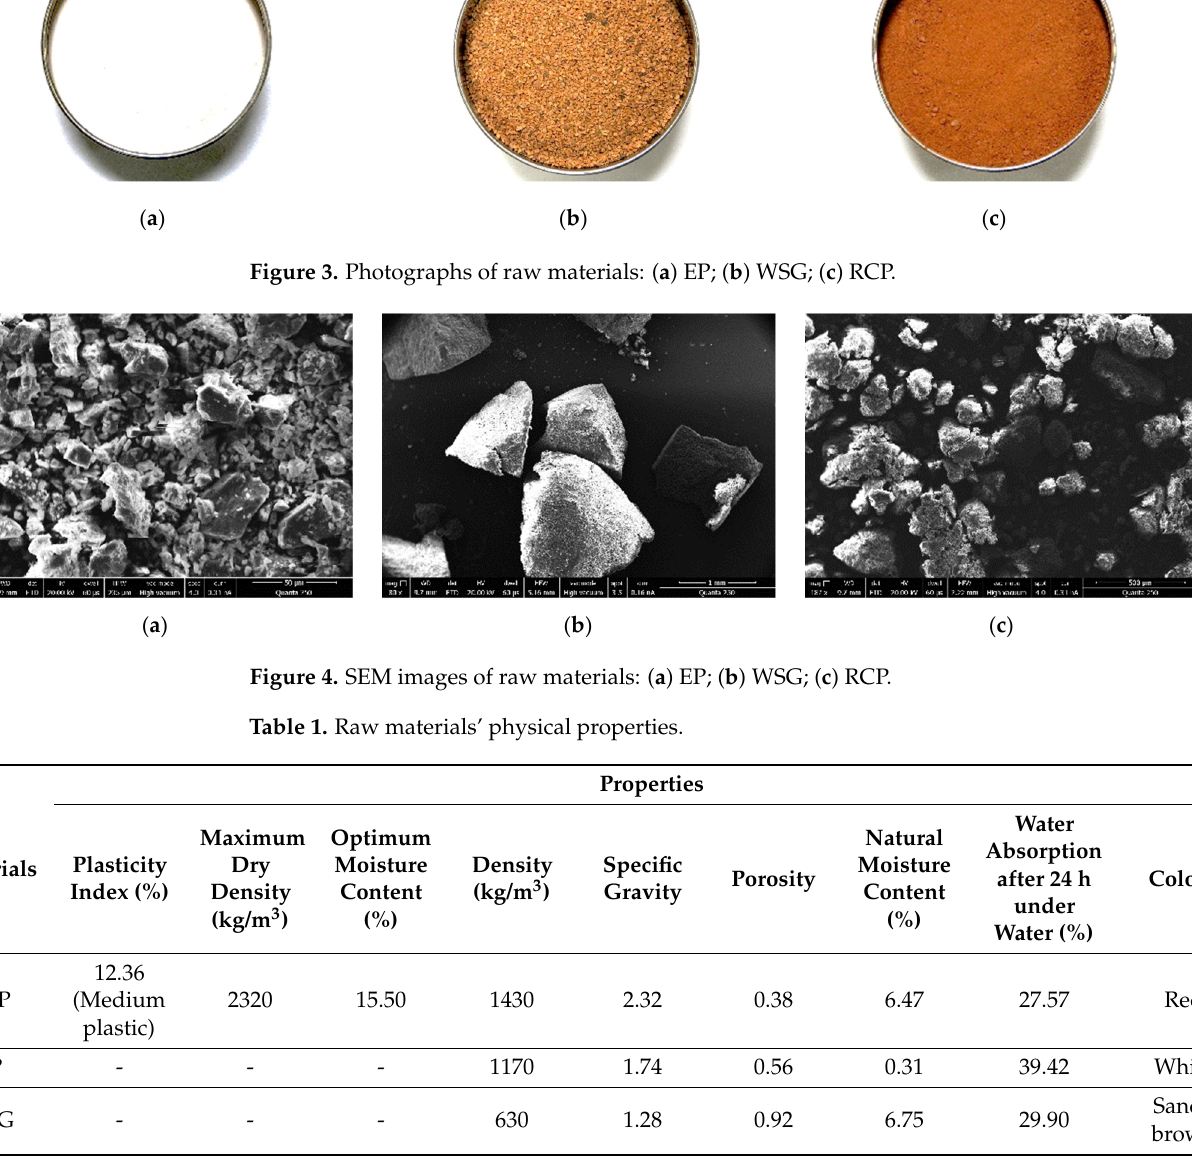
Table 2. Raw materials’ chemical components.